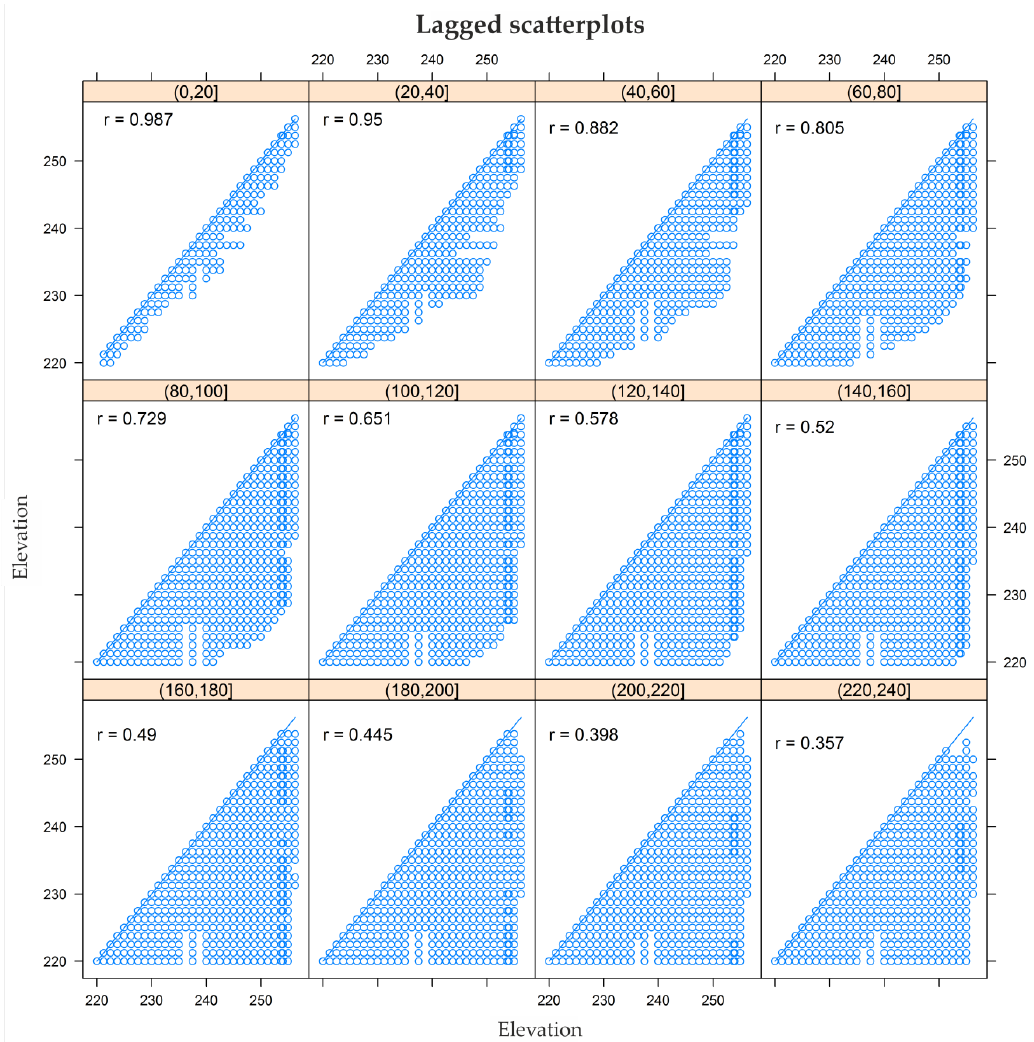
Figure 6. Lagged scatterplot for the examined elevation variable in 12 distance intervals every 20 m, in the Krzemionki mining area and its surroundings.